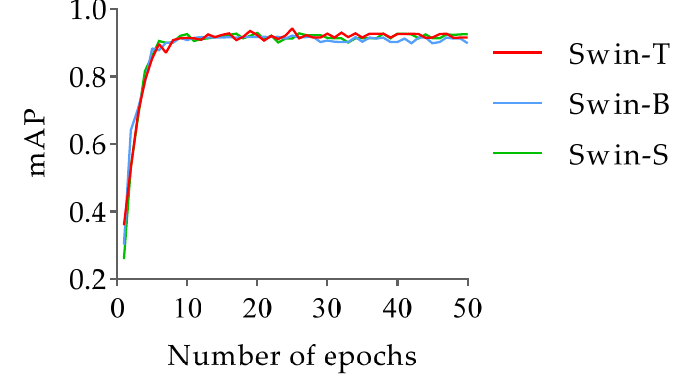
Figure 9. The mAP value changes with the number of iterations.